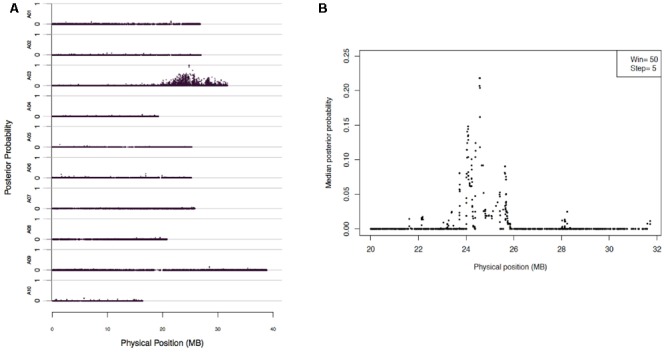
BSR-Seq to map Rcr2 according to the method described by Liu et al. (2012). (A) The physical position of each SNP marker (x-axis) was plotted versus the probability of each SNP marker being in complete linkage disequilibrium with the causal gene (y-axis). (B) Chromosome A03 was scanned by using a window containing 50 SNPs with a step size of five SNPs. Within each window, the median linkage probability obtained from a Bayesian BSA analysis across all the 50 SNPs was determined and was plotted against the middle physical position of the window.